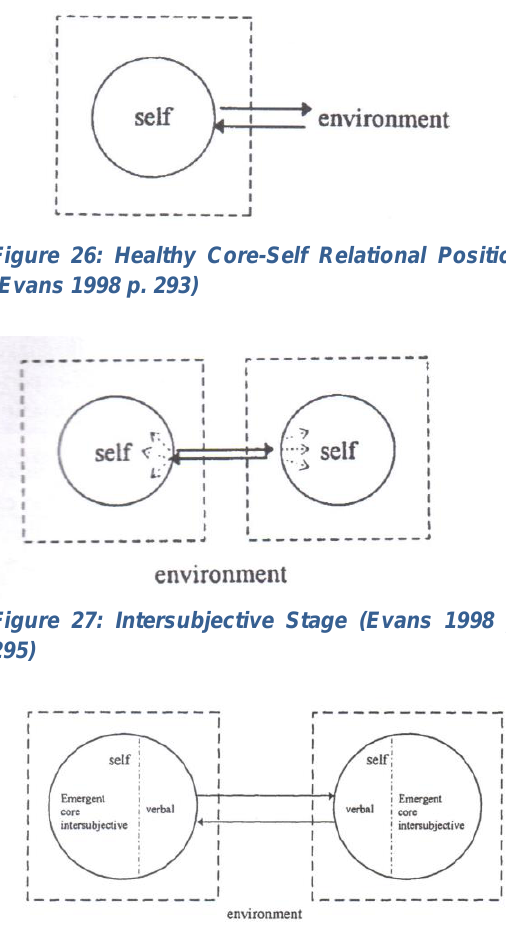
Figure 28: Verbal Stage (Evans 1998 p.